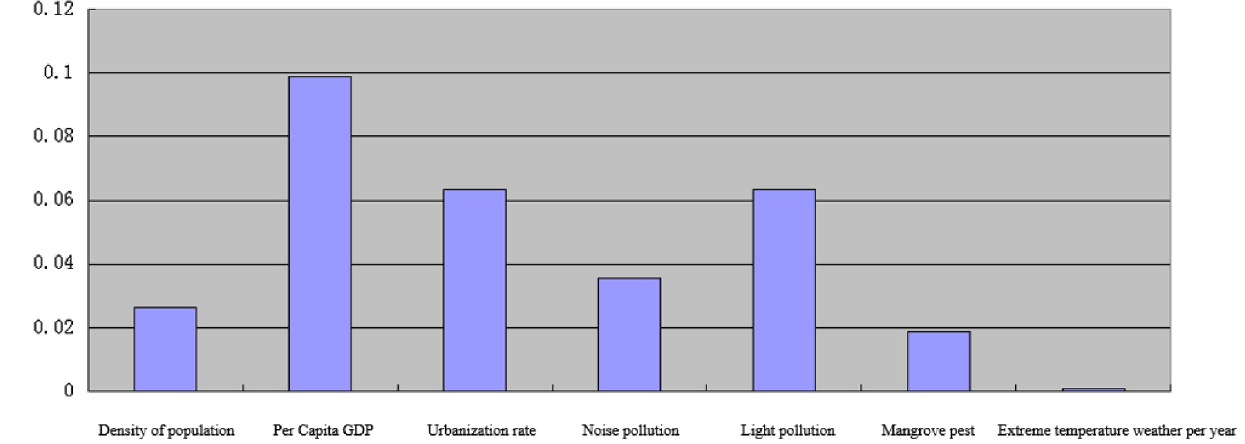
Fig. 4 Comparison diagram of weighted score of each index of the pressure subsystem.